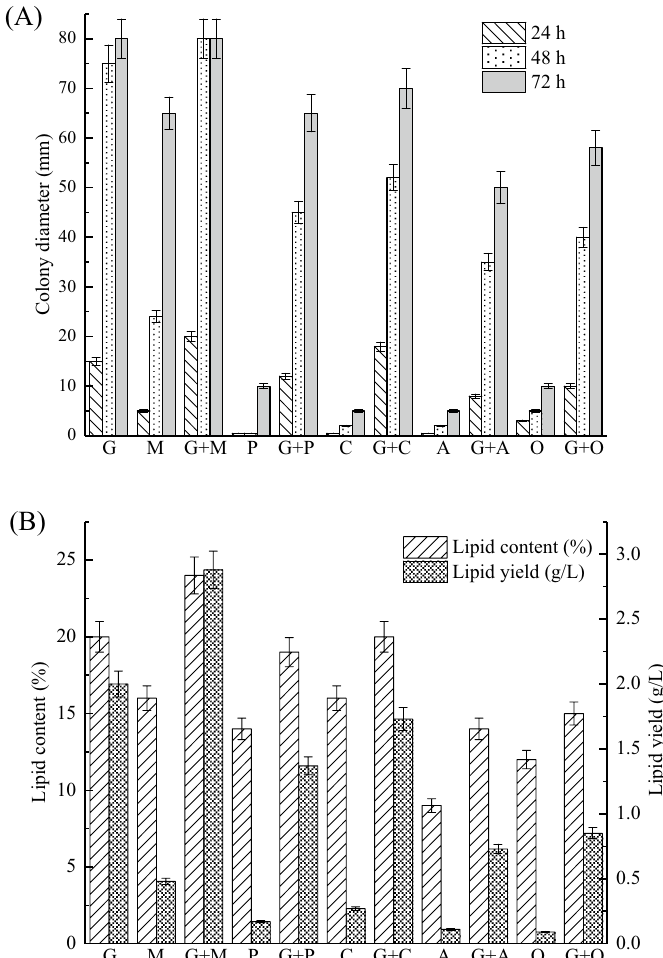
Figure 1. Comparison of cell growth ( A ) and lipid production ( B ) of Mc-MT-2 in batch cultures containing different intermediates. The main carbon source components are abbreviated as follows: G: glucose; M: malic acid; G + M: glucose and malic acid; P: pyruvate; G + P: glucose and pyruvate; C: citric acid; G + C: glucose and citric acid; A: acetic acid; G + A: glucose and acetic acid; O: oxaloacetate; G + O: glucose and oxaloacetate. Values were mean of three independent fermentation experiments. Error bars represent the standard error of the